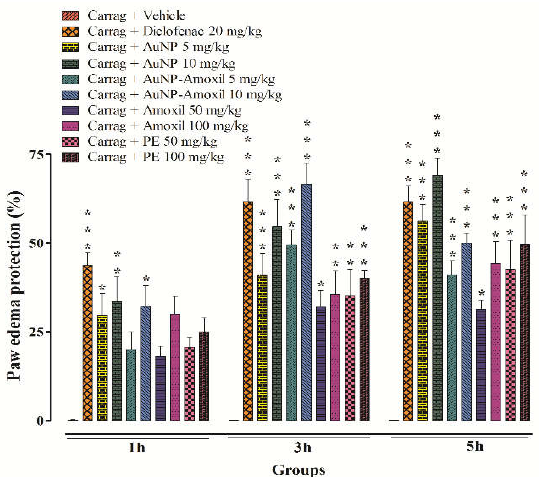
Figure 7. Effect of AuNPs, AuNP-Amoxi conjugate, CFE, and Amoxicillin on carrageenan-induced paw edema in rats. Bars represent mean ± SEM. * p < 0.05, ** p < 0.01, *** p < 0.001 compared to the